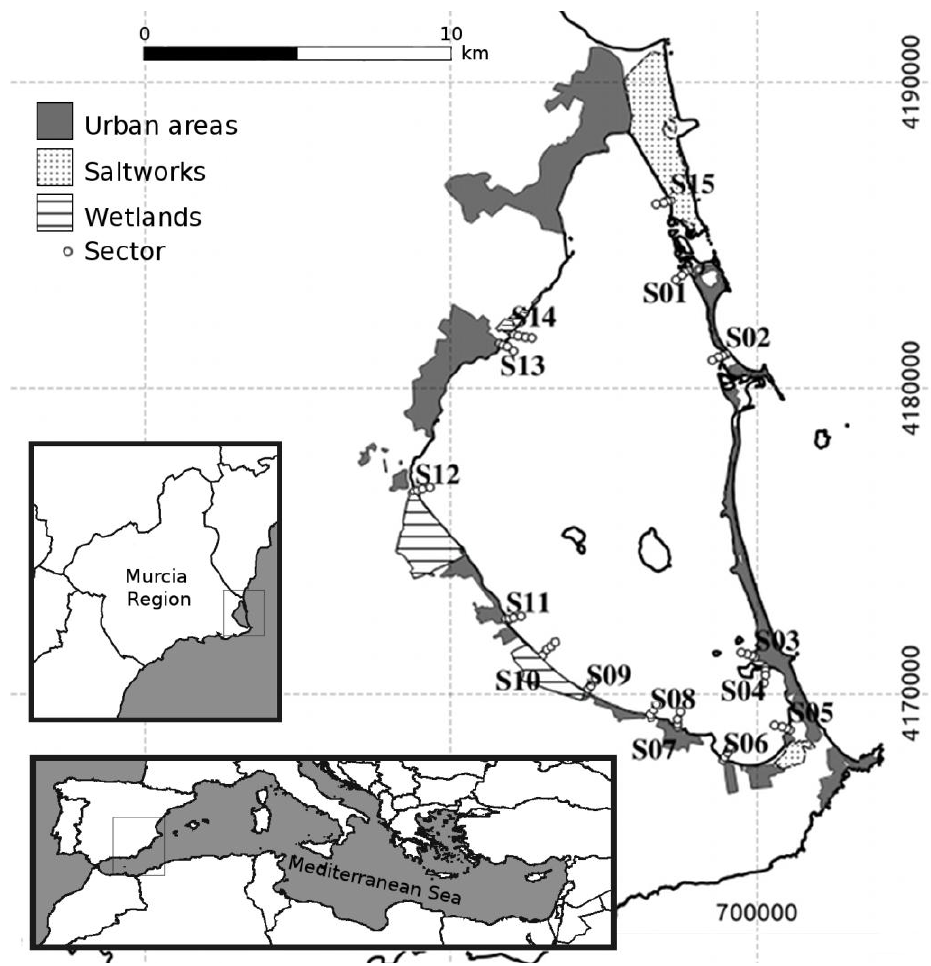
Figure 1. General map of the Mar Menor Lagoon showing the 15 bird sampling stations within three sectors: the urban areas, the active saltpans, and the wetlands (natural saline steppe areas and other phreatophytic formations). The map projection corresponds to ED50 UTM 30N.